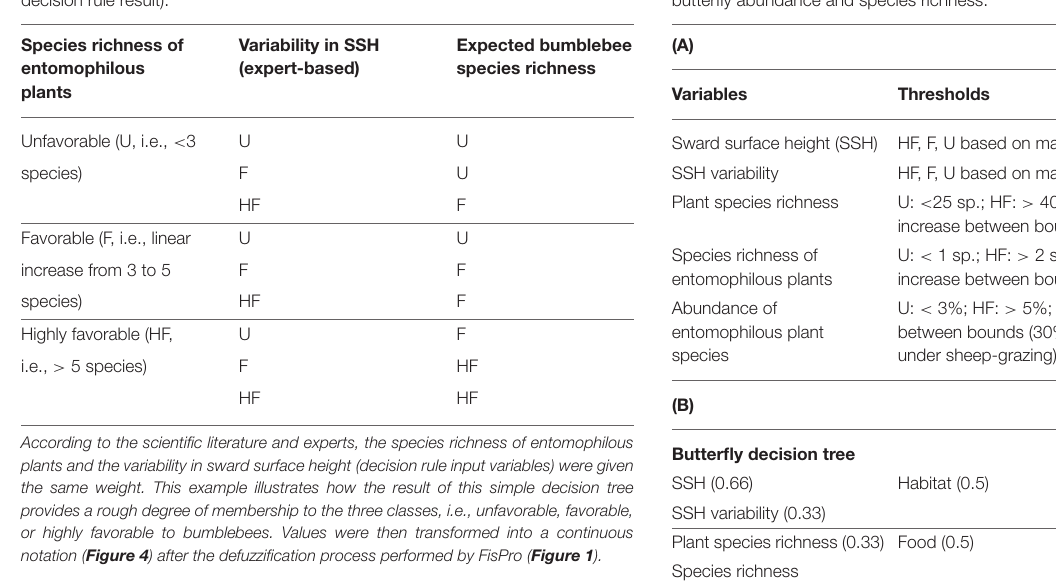
TABLE 3 | (A) Predictive variables, threshold levels and (B) final decision tree of butterfly abundance and species